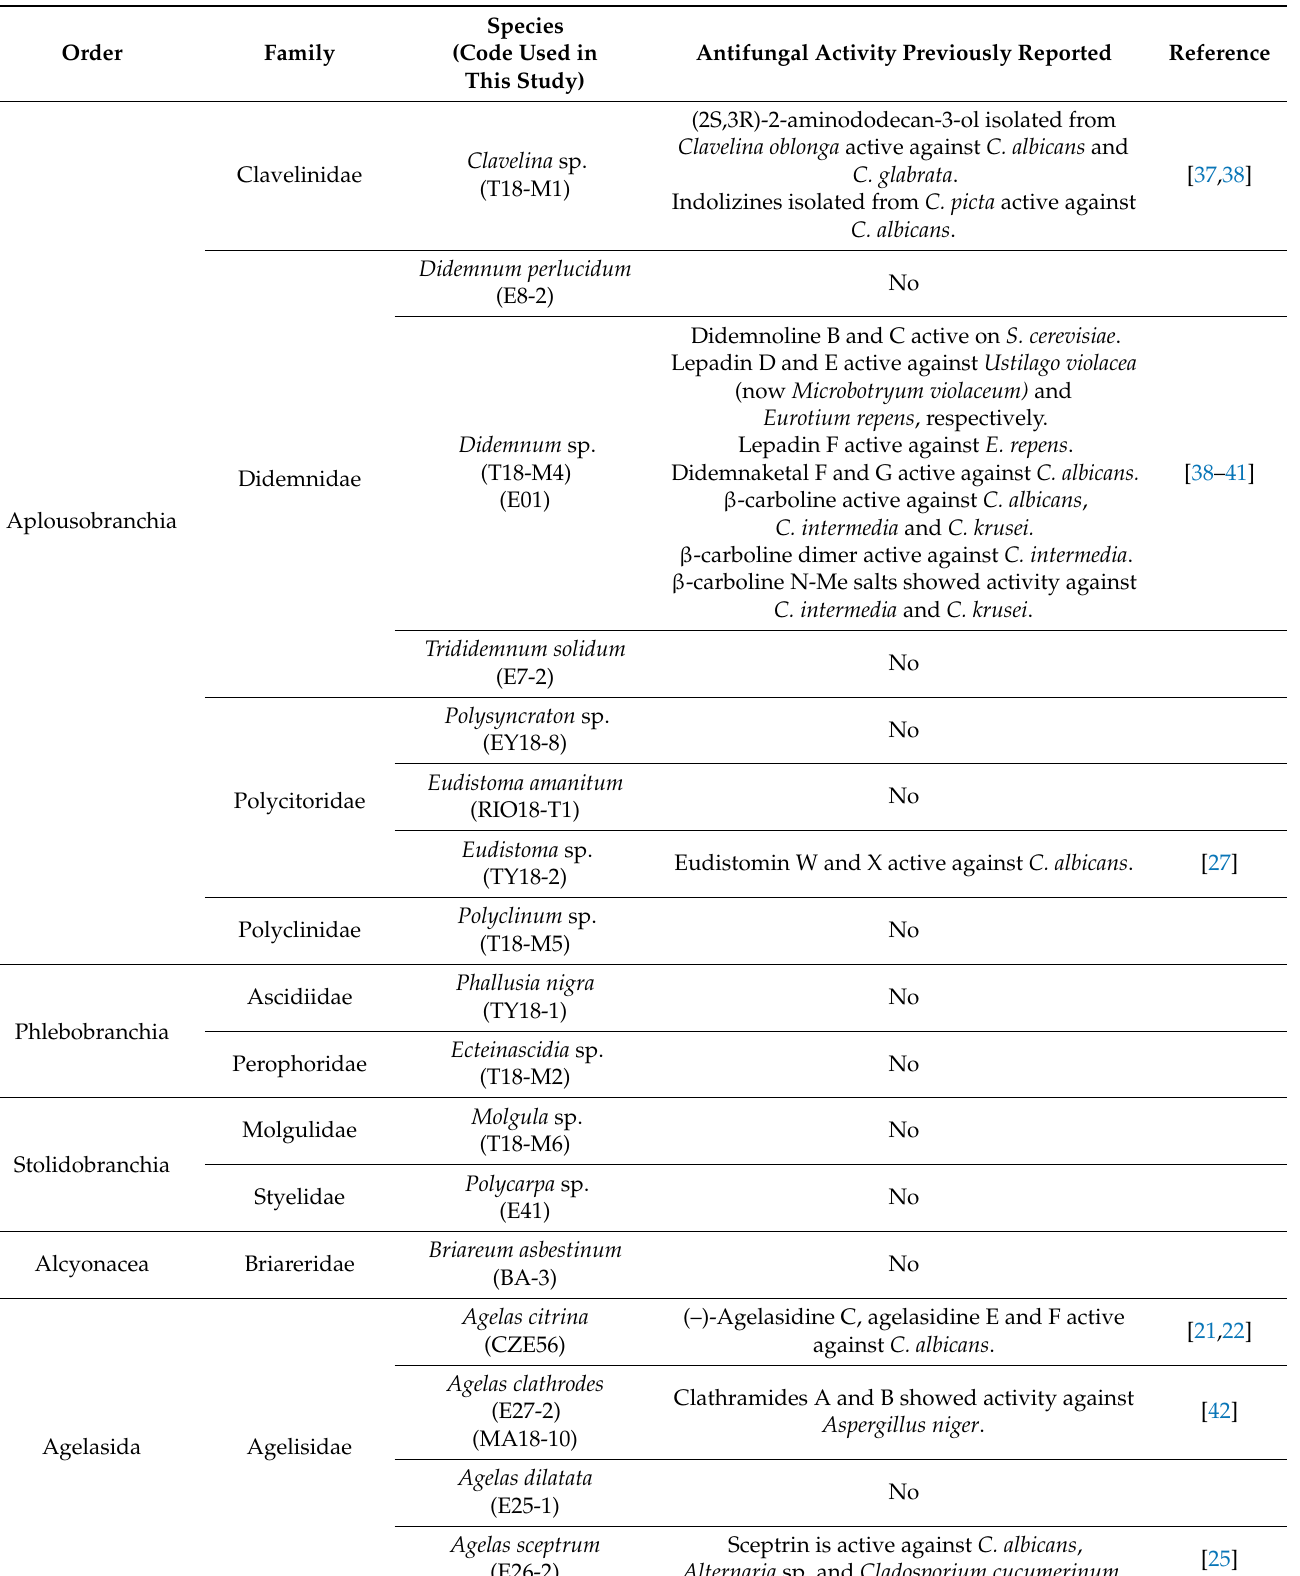
Table 10. Taxonomic information and previously reported antifungal activity of the marine species studied in this